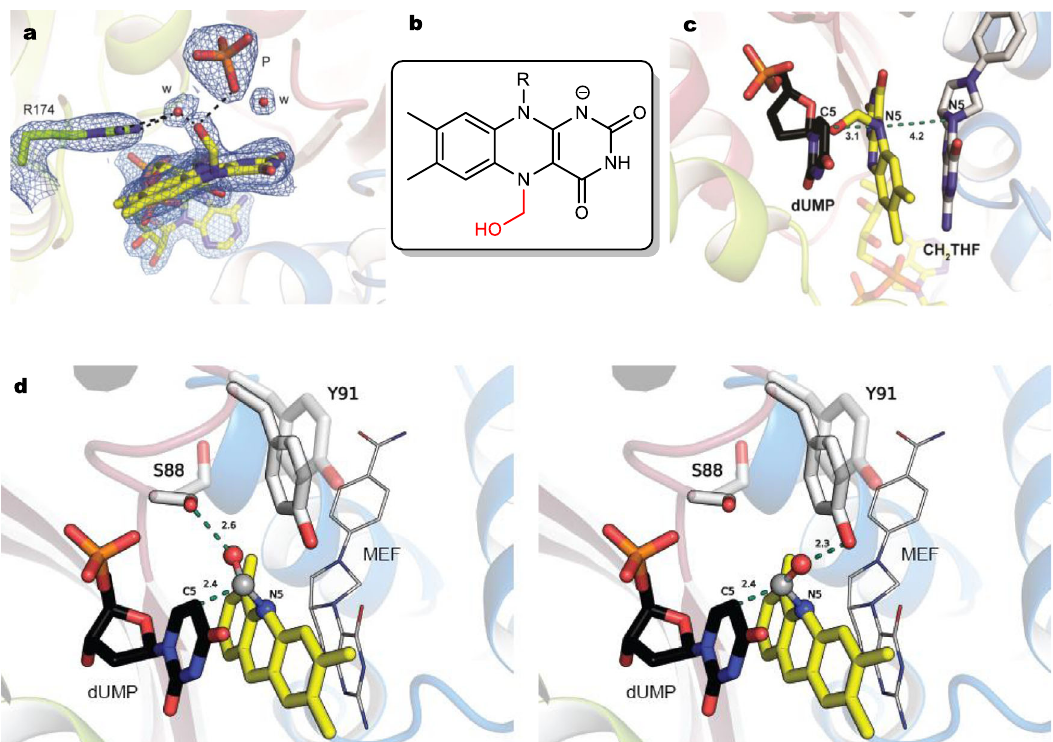
Fig. 3 Activation of CH 2 O by T. maritima ThyX and structural capture of the carbinolamine fl avin intermediate. a Section of the 2mF0-DFc electron density contoured at 1 σ around the fl avin carbinolamine of ThyX obtained by the anaerobic reaction of CH 2 O with FADH − (FADH − • CH 2 O). Waters and a phosphate molecule are labeled w and P, respectively. R174 participates in dUMP activation 24 and interacts with an active site water molecule. b Chemical structure of the N5 fl avin-carbinolamine adduct. c Model of ThyX in complex with the fl avin carbinolamine, dUMP, and folate. The model was obtained by superimposing the crystal structure of FADH − • CH 2 O complex with the structure of ThyX in complex with dUMP and folate (pdb, 4gt9). d Structural model of ThyX in complex with the fl avin carbinolamine, dUMP, and folate, in which the carbinolamine is properly oriented for attack by the activated C5-dUMP. This SN2 is likely assisted by two residues, S88 and Y91, which are conserved among ThyX enzymes. This model shows the different orientations adopted by these residues in two different structures of ThyX and they may assist the SN2 and departure of the β -hydroxyl leaving group of the fl avin carbinolamine. The structures used for this model are: (i) ThyX FADH − soaked with 20 mM CH 2 O vs (ii) pdb